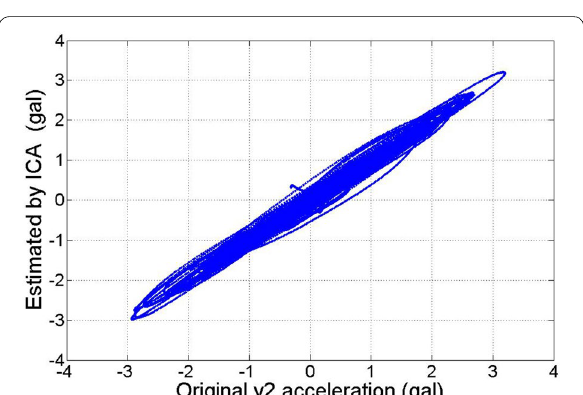
Fig. 17 Correlation between the original and restored signal (correlation coefficient: